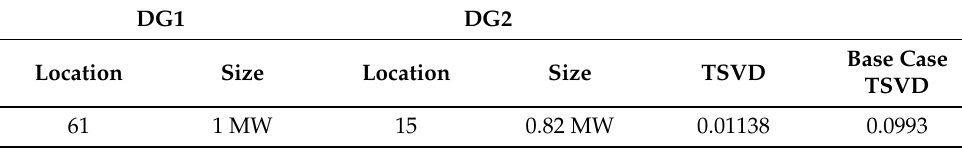
Table 5. PG and E 69 bus test system: Optimal placement of DG units.